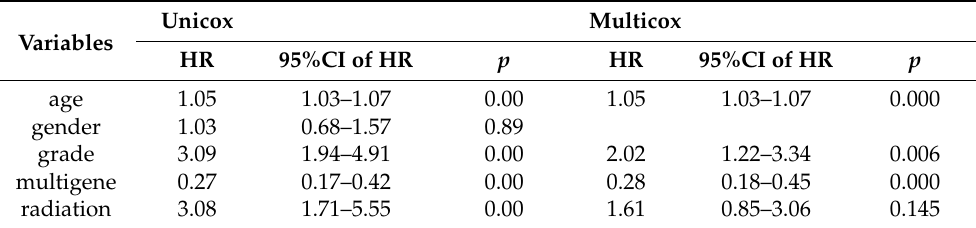
Table 1. Univariate and multivariate Cox analysis identified independent prognostic